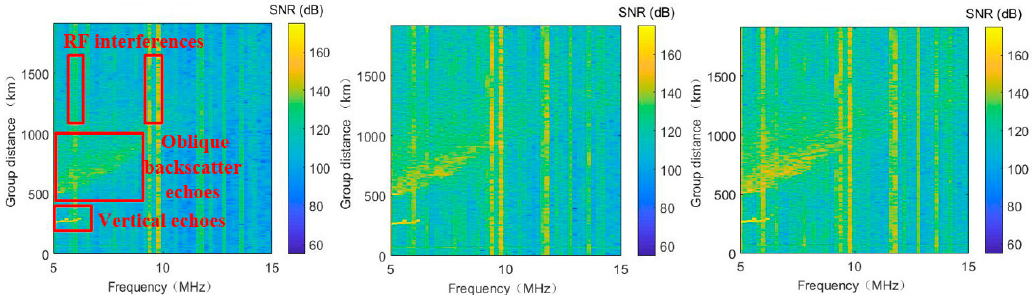
Figure 8. Map showing the location of the experiment in Wuhan, Xiantao, Hubei province, China and the antenna pointing direction in azimuth.